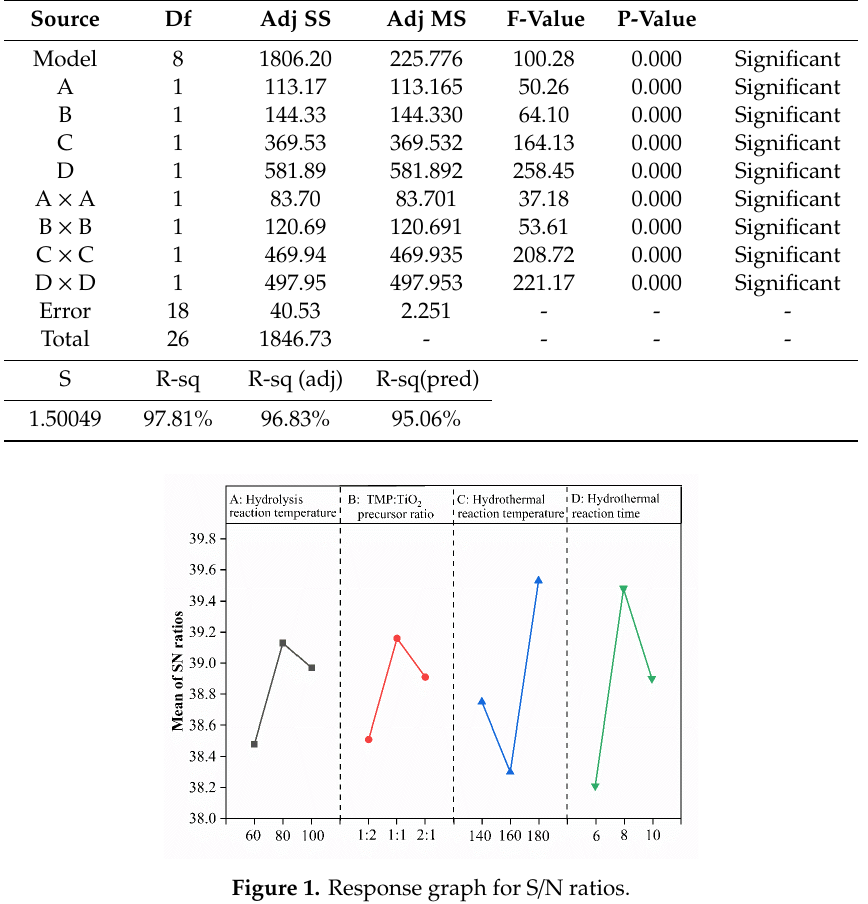
Table 1. Analysis variance of removal e ffi ciency.